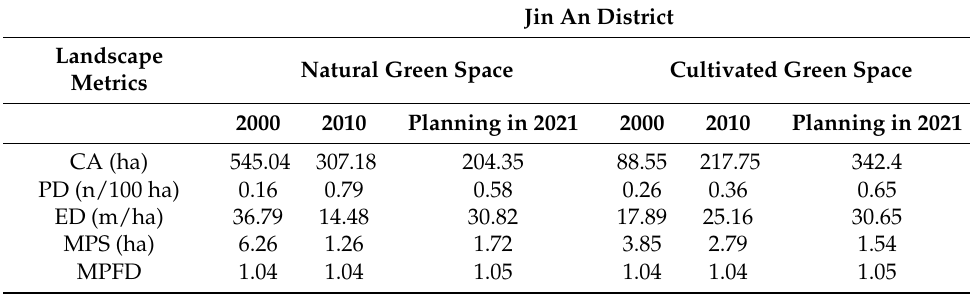
Table A3. The comparison of landscape metrics on class level of Jin An